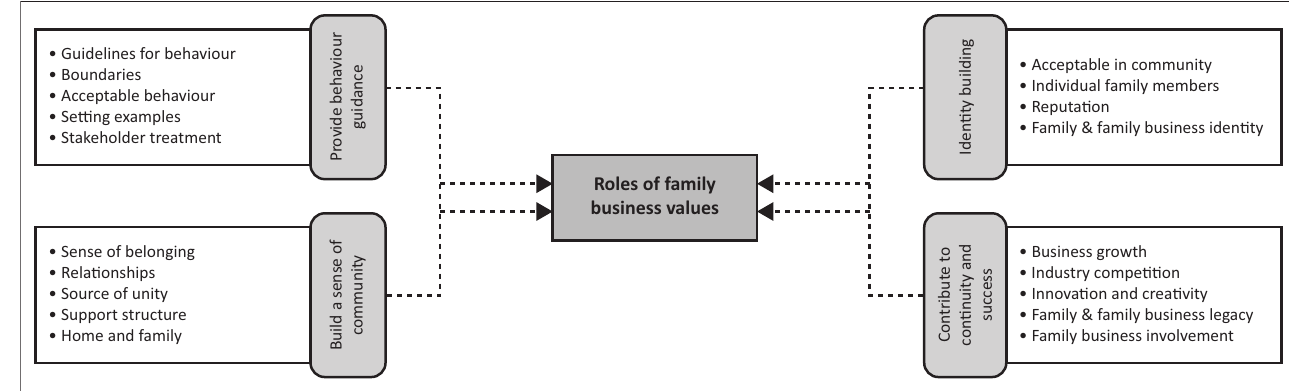
FIGURE 1: The roles of family business values in indigenous black South African family